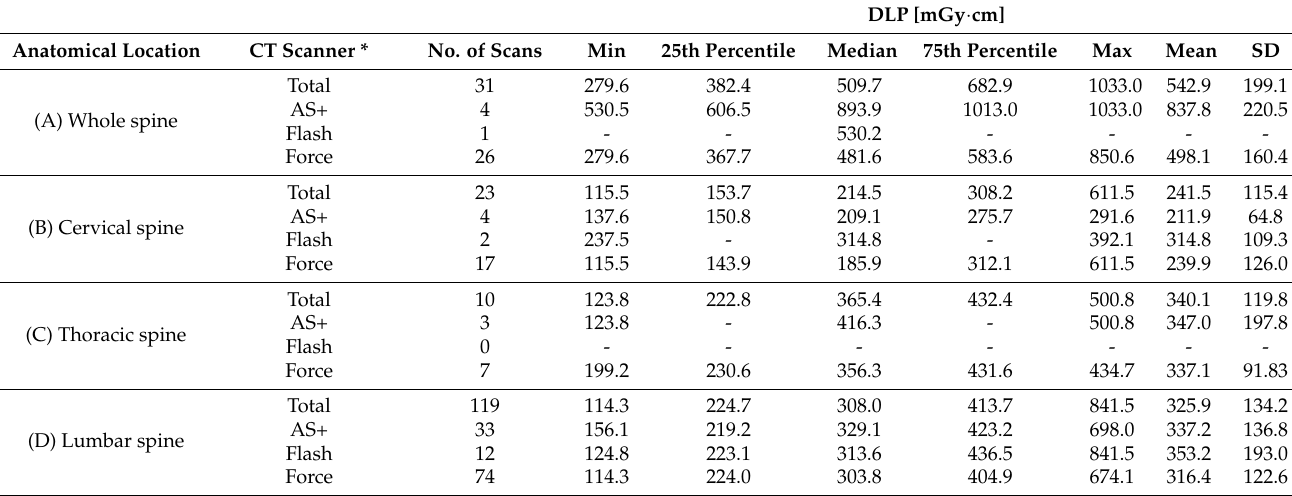
Table 3. Dose-length product (DLP) of CT